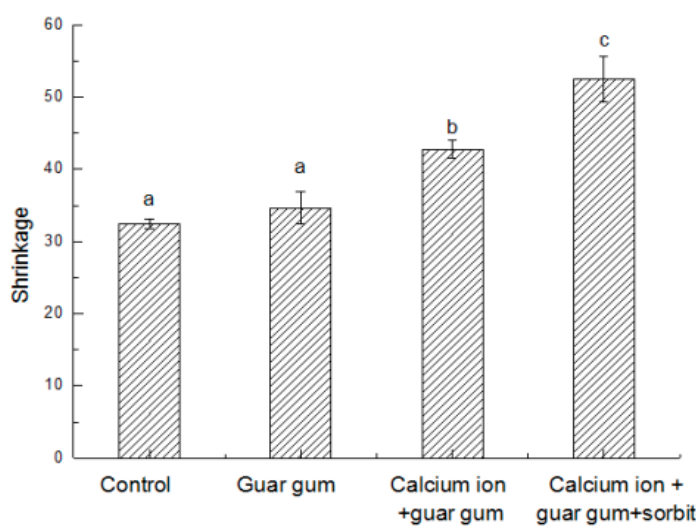
Figure 5. Comparison on the shrinkage of French fries produced by different methods.